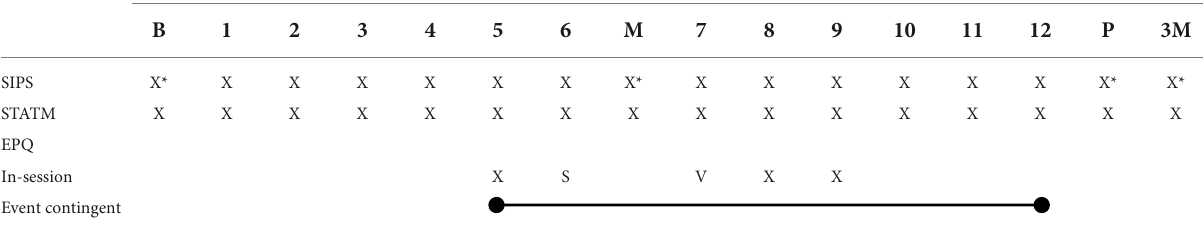
TABLE 1 Study assessment schedule.